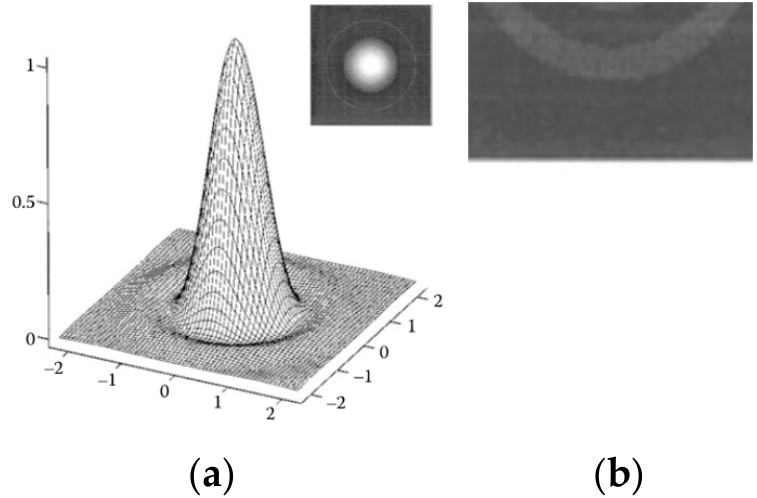
Figure 2. ( a ) Image by an optical system of a point object at infinity, with the central spot often referred to as the Airy disc; ( b ) Rayleigh resolution distance is equal to the Airy disc radius. Figure 3 illustrates schematically how the pixel dimension relative to the size of the Airy disc affects the amount of energy that is incident on the detector pixel. The radius of the Airy disc is dependent on the optical system, r A = 1.22 λ F/#. The wavelength is denoted by λ , and the instrument is characterized by its ratio f/D = F/# . D is the aperture diameter, f is the focal distance, and F/# (sometimes also f/#) is the f-number. The pixel size is equal to the Airy disc diameter in the third illustration from the left. The two pixels on its left are larger by 20% and 40% than the diameter of the Airy disc. Both also include two point-sources positioned at the Rayleigh resolution limit. In this case, the pixel dimension acts to define the instrument resolution. The pixel on the furthest right would resolve the two point-sources at the Rayleigh’s resolution limit, but only if it were correctly centered.